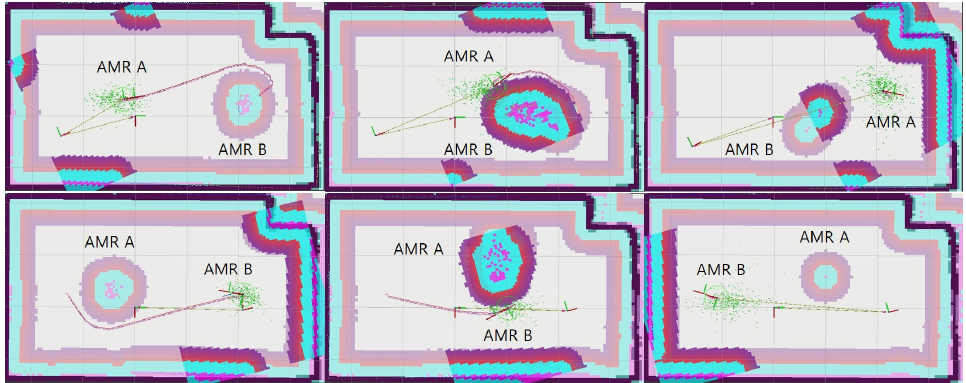
Figure 9. The cost maps of AMR A and B are estimated by the